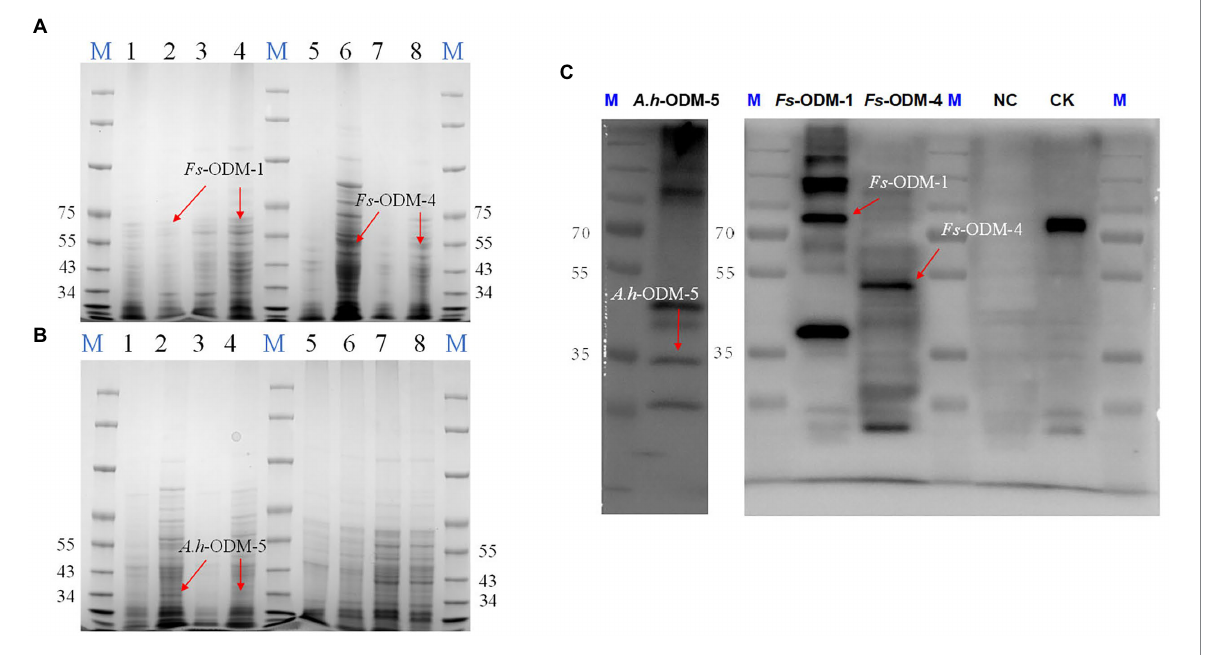
FIGURE 7 SDS-PAGE and WB detection of ODMs recombinant protein. (A) SDS-PAGE detection of Fs -ODM-1, Fs -ODM-1Y (induced), Fs -ODM-4, and Fs -ODM-4Y (induced) recombinant protein (columns 1–8 correspond to Fs -ODM-1-37, Fs -ODM-1-37Y, Fs -ODM-1-16, Fs -ODM-1-16Y, Fs -ODM-4-16, Fs -ODM-4-16Y, Fs -ODM-4-37, and Fs -ODM-4-37Y, respectively); (B) SDS-PAGE detection of A.h -ODM-5, A.h -ODM-5Y (induced), NC, and NCY (induced) recombinant protein(columns 1–8 correspond to A.h -ODM-5-16, A.h -ODM-5-16Y, A.h -ODM-5-37, A.h -ODM-5-37Y, NC-16, NC-16Y, NC-37, and NC-37Y, respectively); (C) Western blot (WB) detection of A.h -ODM-5-16Y(induced), Fs -ODM-1-16Y(induced), Fs -ODM-4-16Y(induced), and NC-16Y (induced) recombinant protein. Notes: “ − 16” means culture at 16 ° C and “ − 37” means culture at 37 ° C. CK was used recombinant 16 tag protein produced by Lianmai Biology. It is a recombinant protein with a size of 68.5 kd and is expressed in E. coli . It is often used as a positive control for WB detection of any of the 16 Tags (include His-tag).